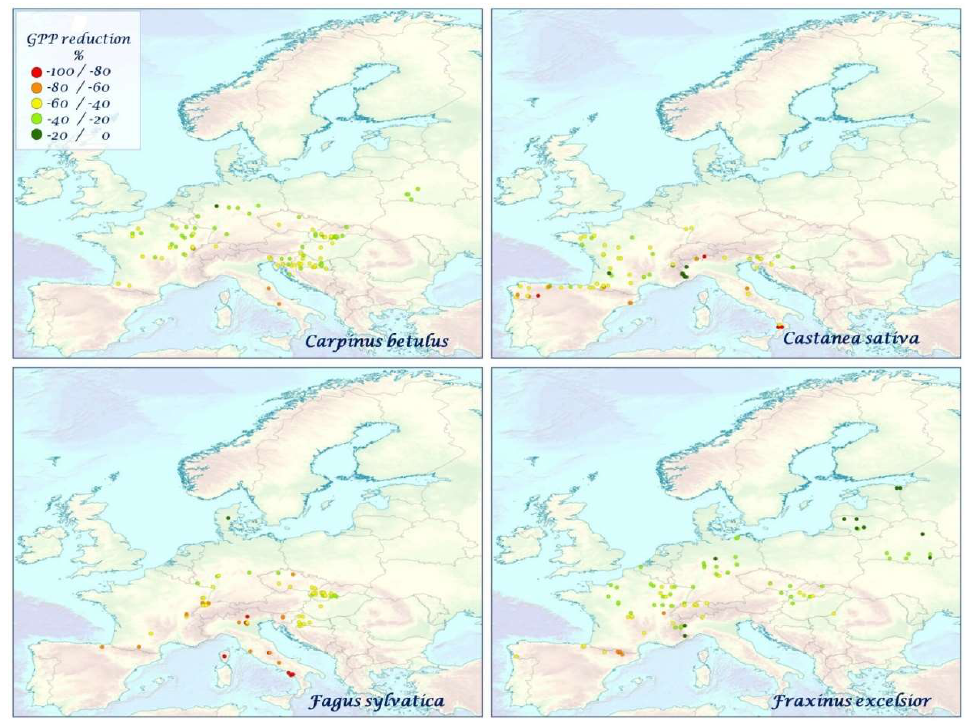
Figure 6. The mean species–specific GPP reduction (%) for C. betulus, C. sativa, F. sylvatica, F. excelsior over the time period 2000–2010.